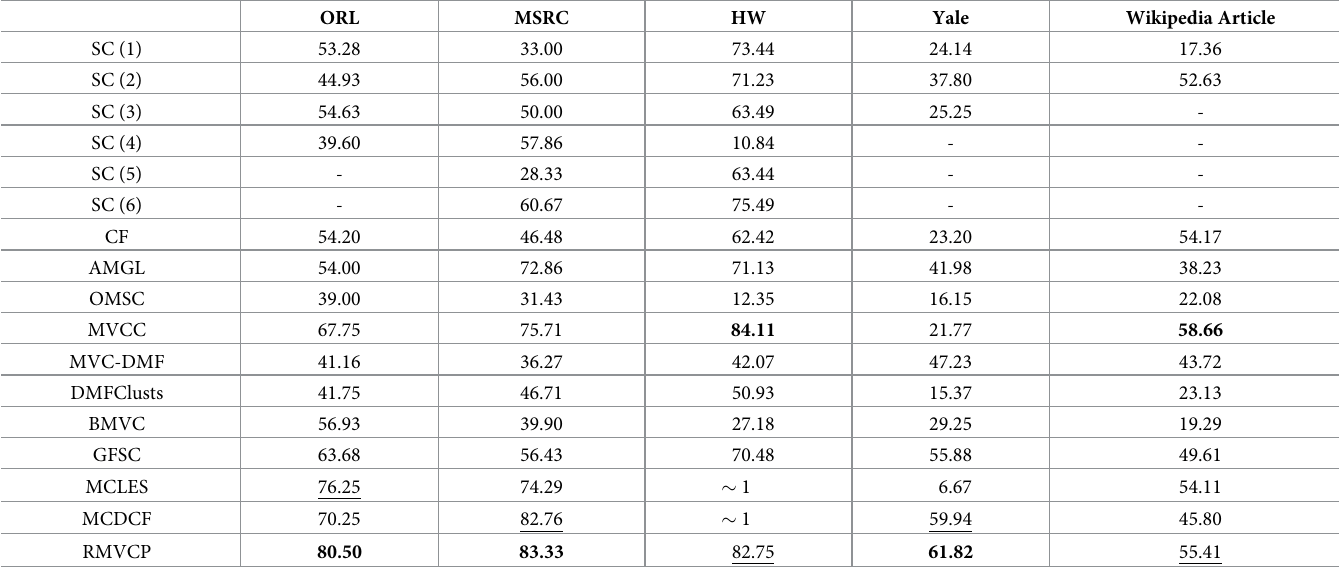
Table 2. Comparison of algorithms on five datasets for Acc.